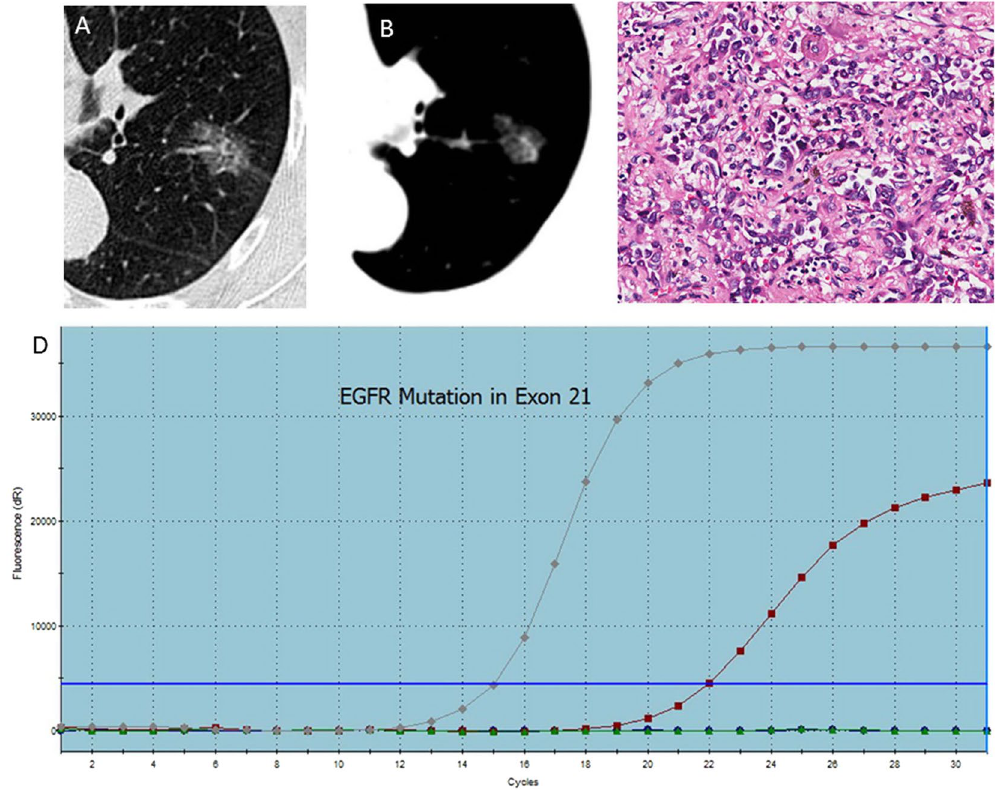
Figure 5. A non-smoking woman with lung adenocarcinoma in the left upper lobe, where PCR images ( A ) and pathological picture ( D ) show that the subtype is exon 21 mutation. CT images ( B,C ) show a subsolid lump with spiculated